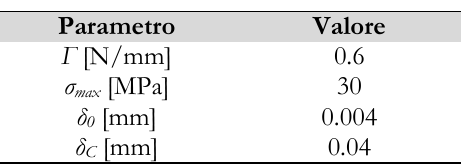
Tabella 1: Parametri del modello di zona coesiva.